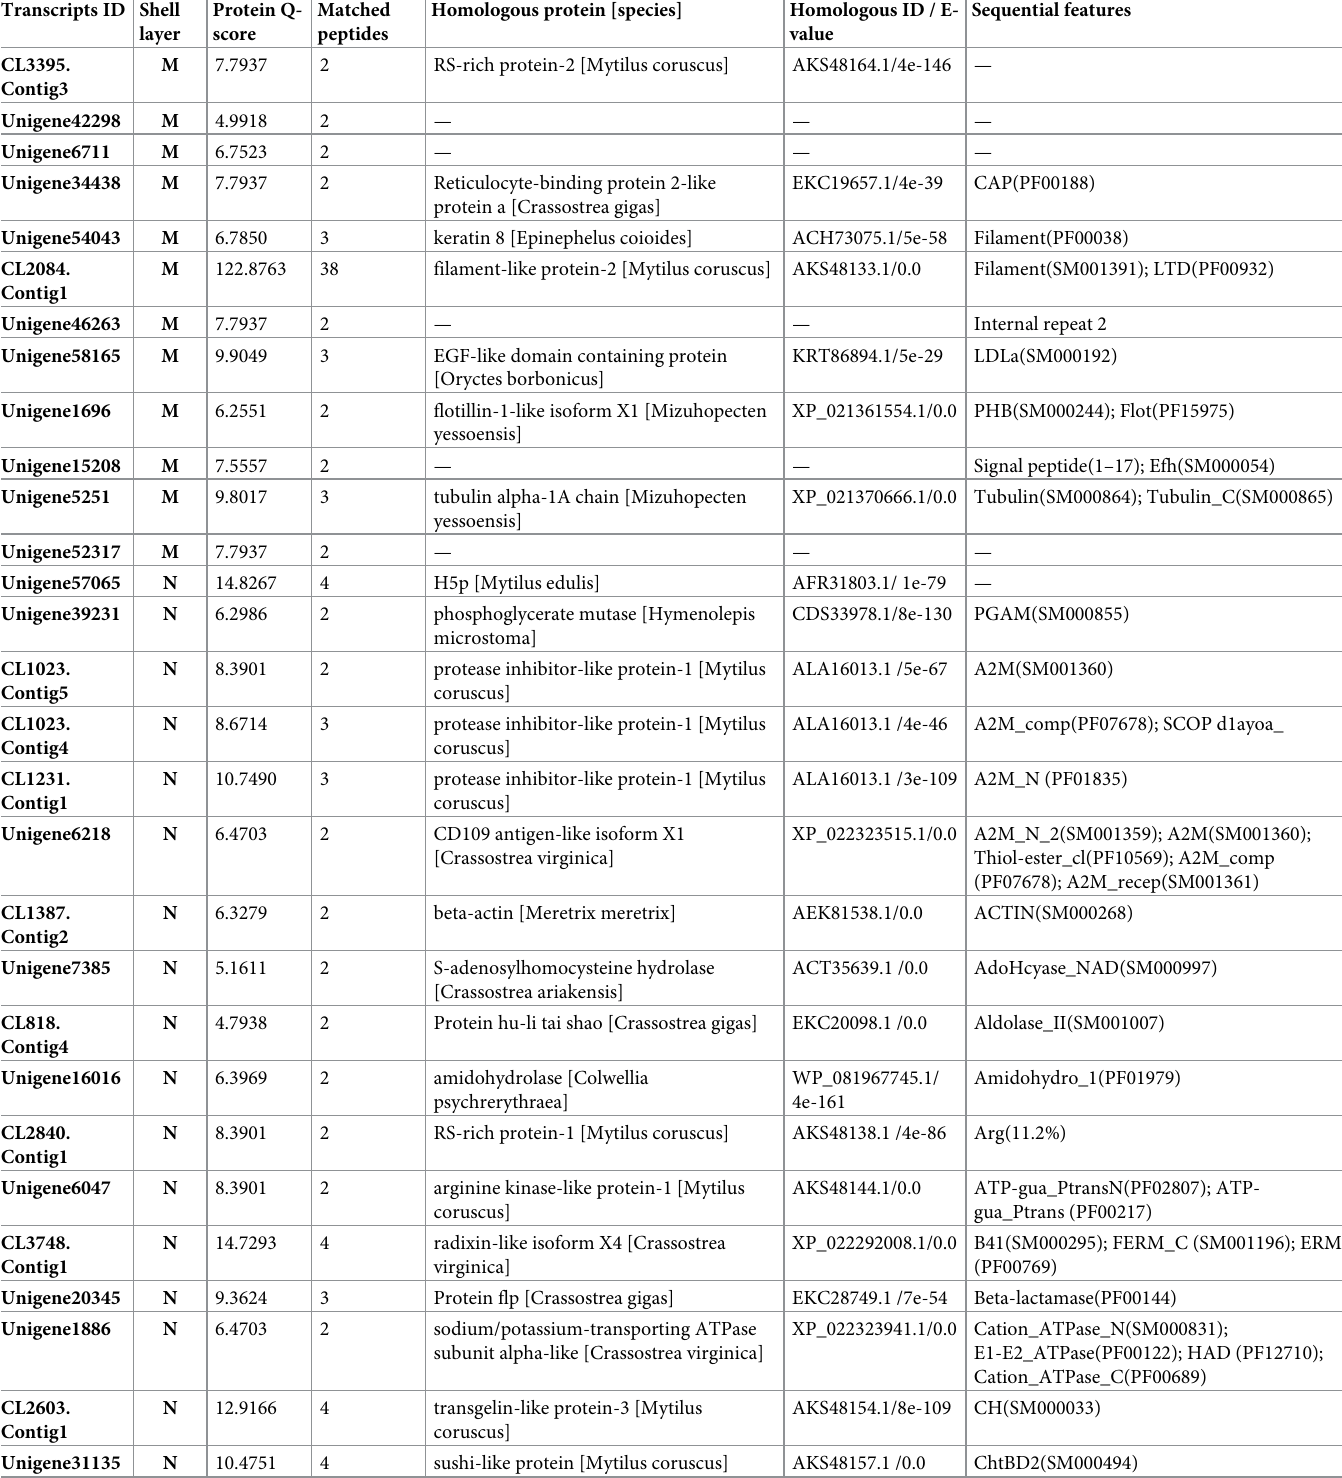
Table 4. SMPs identified with more than two matched peptides from the P . viridis shell by LC-MS/MS. The MS/MS spectra were used for searching against the Illu- mina-sequencing based P . viridis mantle transcriptome using Mascot software. N represents the nacre layer and M represents the myostracum